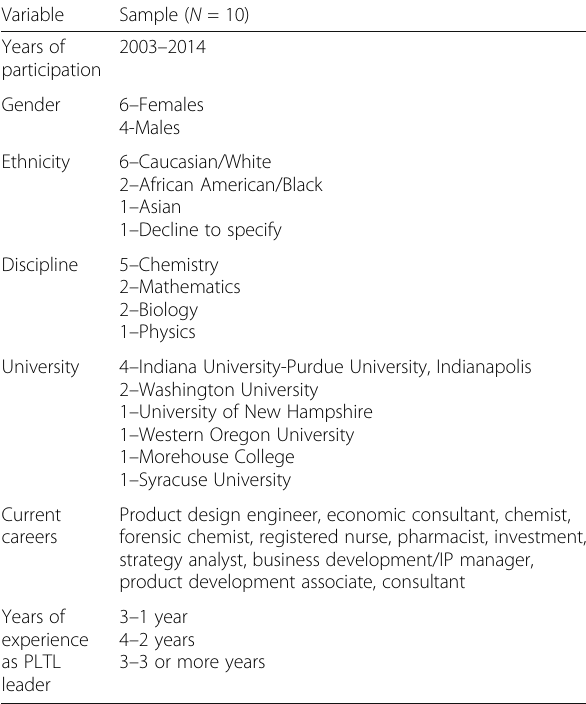
Table 2 Pre-interview survey information: participant demographics and current